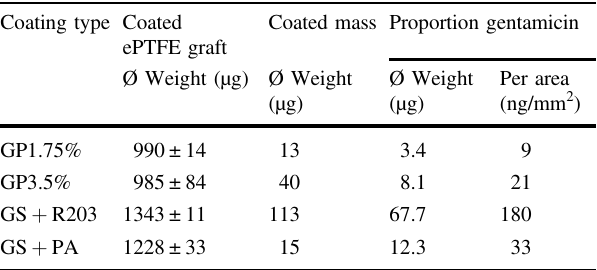
Table 2 Gentamicin loading among the different coating types on cylindrical ePTFE graft samples Coating type Coated Coated mass Proportion ePTFE graft